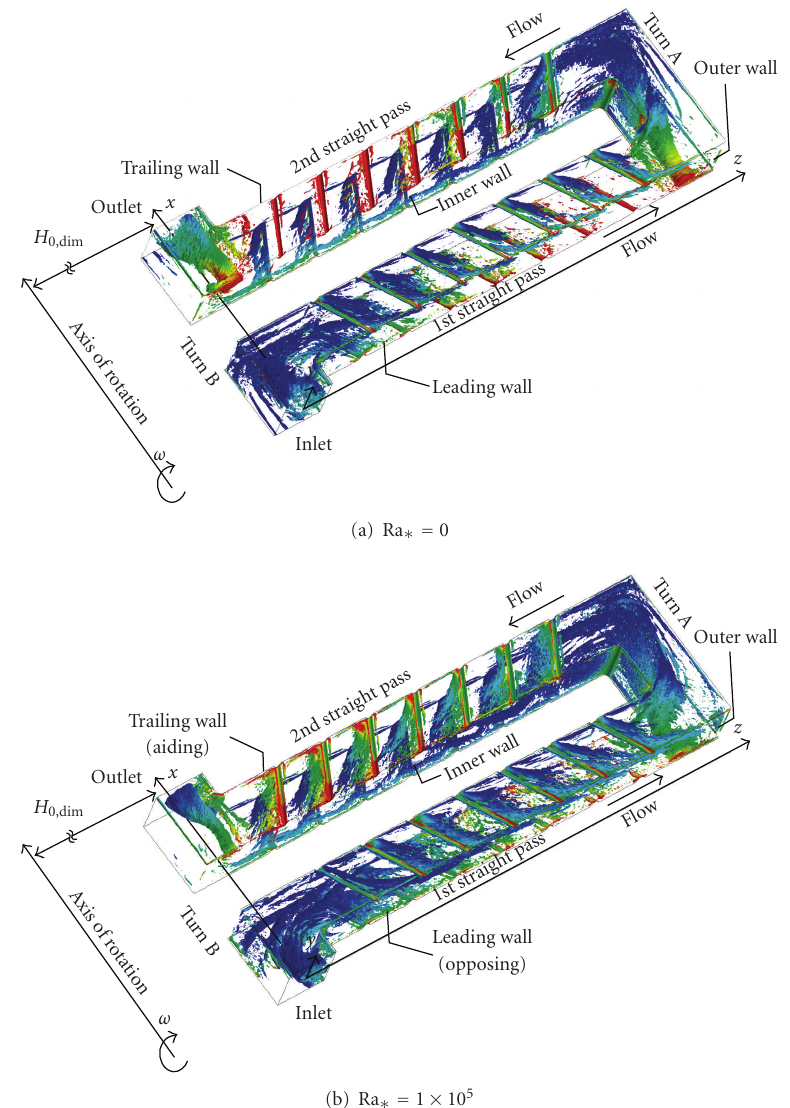
Figure 10: Time-averaged vortex structure visualized as isosurface of Q = 10 with the color contour of fluid temperature (60 ◦ rib NP, Re ∗ = 3000, and Ro ∗ =